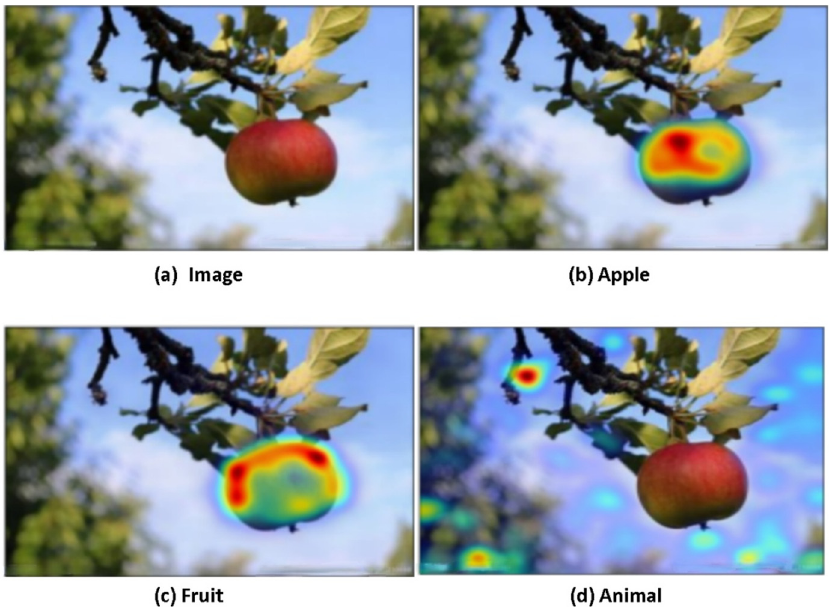
Figure 4. The proposed knowledge-updated multimodal object detection model can detect the types of objects. ( a ) is the original image used for object detection verification. ( b ) is the heat distribution map of the region of interest when the word “apple” is input to the model. ( c ) is the heat distribution map of the region of interest when the word “fruit” is input to the model. ( d ) is the heat distribution map of the region of interest when the word “animal” is input to the model. According to the above results, the model can clearly distinguish the category, name, and location of the object. This model can think and judge independently; an apple is a fruit, but not an animal.